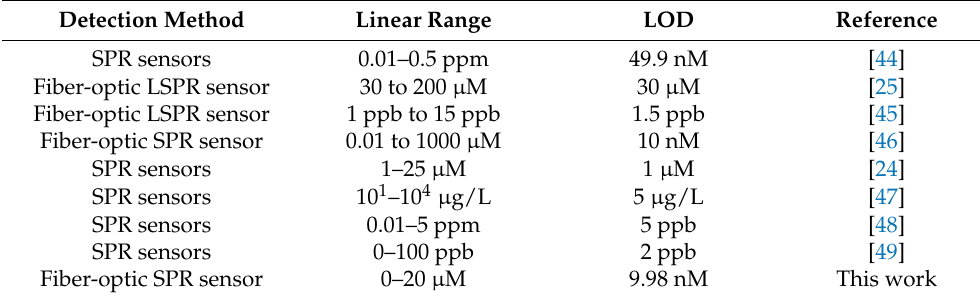
Figure 9. SPR signal responses of Hg 2+ detection: ( a ) different concentrations of Hg 2+ samples (0–20 µM); ( b ) linear range for Hg 2+ determination at the concentrations ranging from 80 to 200 nM. Table 1. Comparison of this work with some published assays for Hg 2+ ion detection by SPR